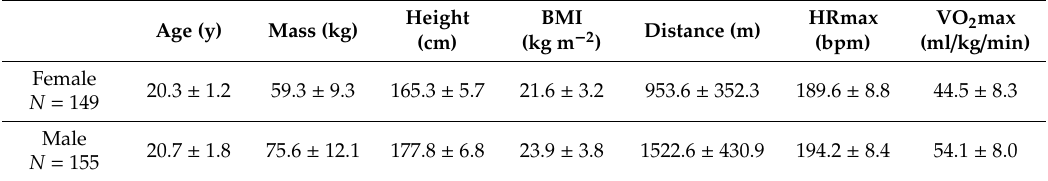
Table 1. Main characteristics of the study group.